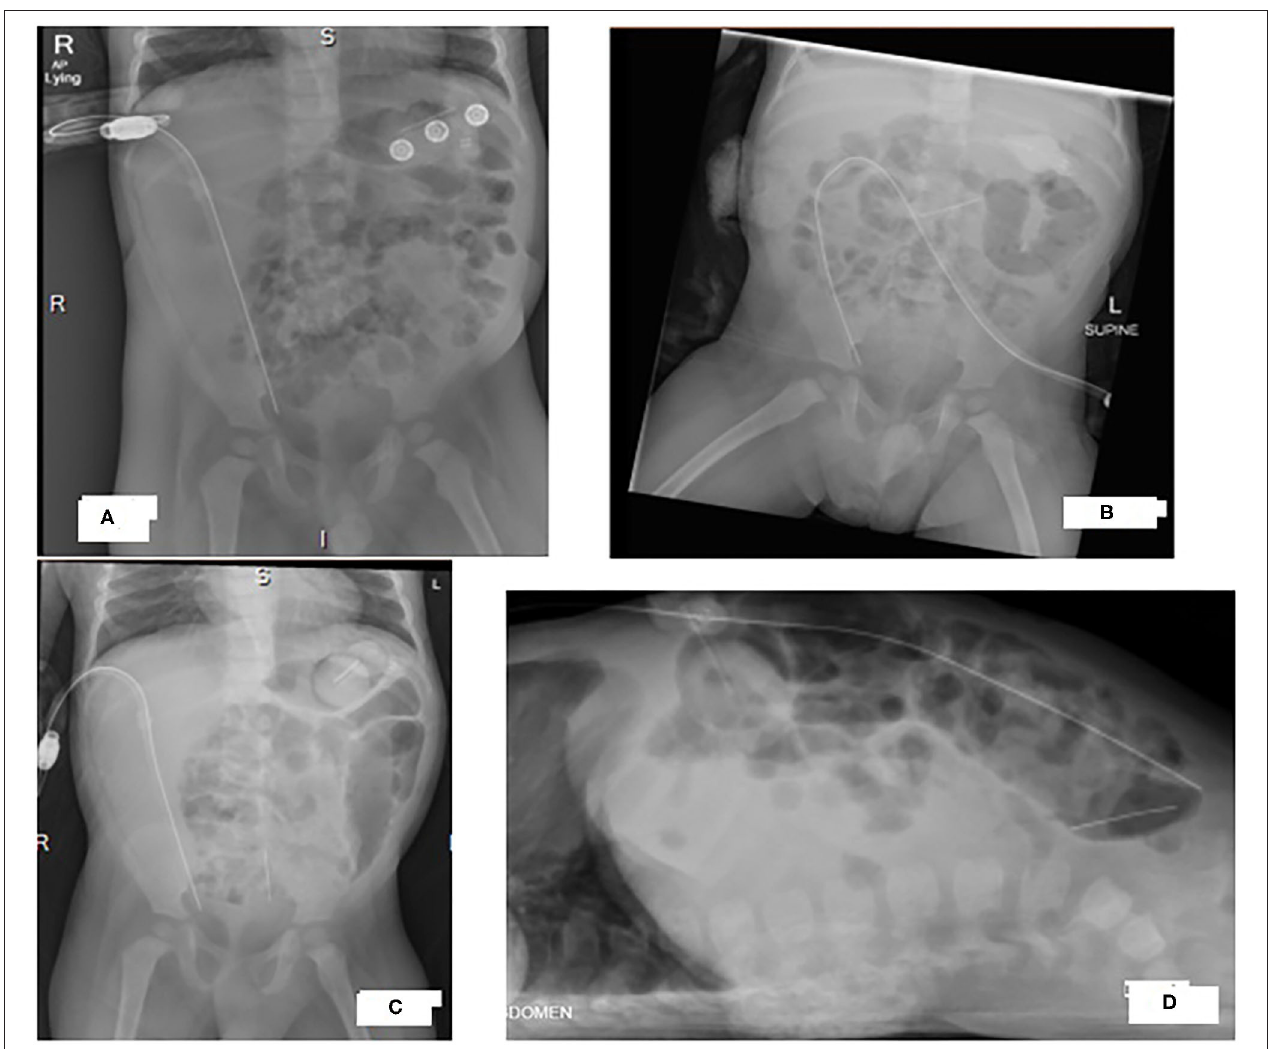
FIGURE 1 | X-rays of our patient’s abdomen showing progression of a radio-opaque horizontal thin object from the upper abdomen to the pelvis. (A) Antero-posterior view at 20-month, (B) Antero-posterior view at 22-month (C) Antero-posterior view and (D) cross table view at 24-month.